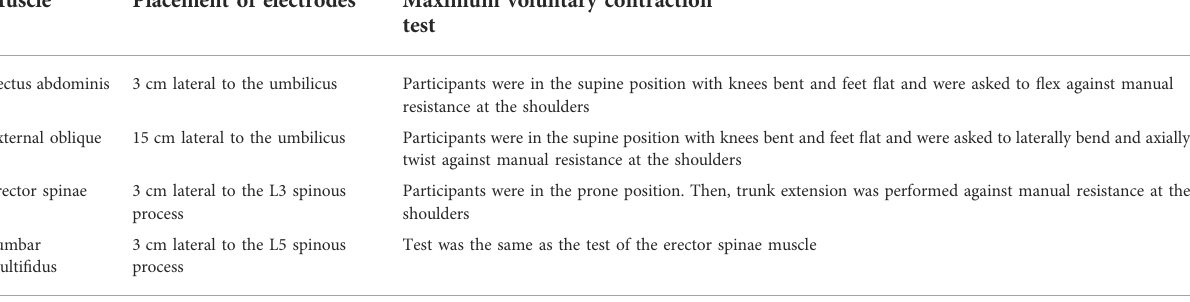
TABLE 1 Placement of surface electromyography electrodes and measurement of the maximum voluntary contraction of trunk muscles. Muscle